Question: State the chart type depicted above.
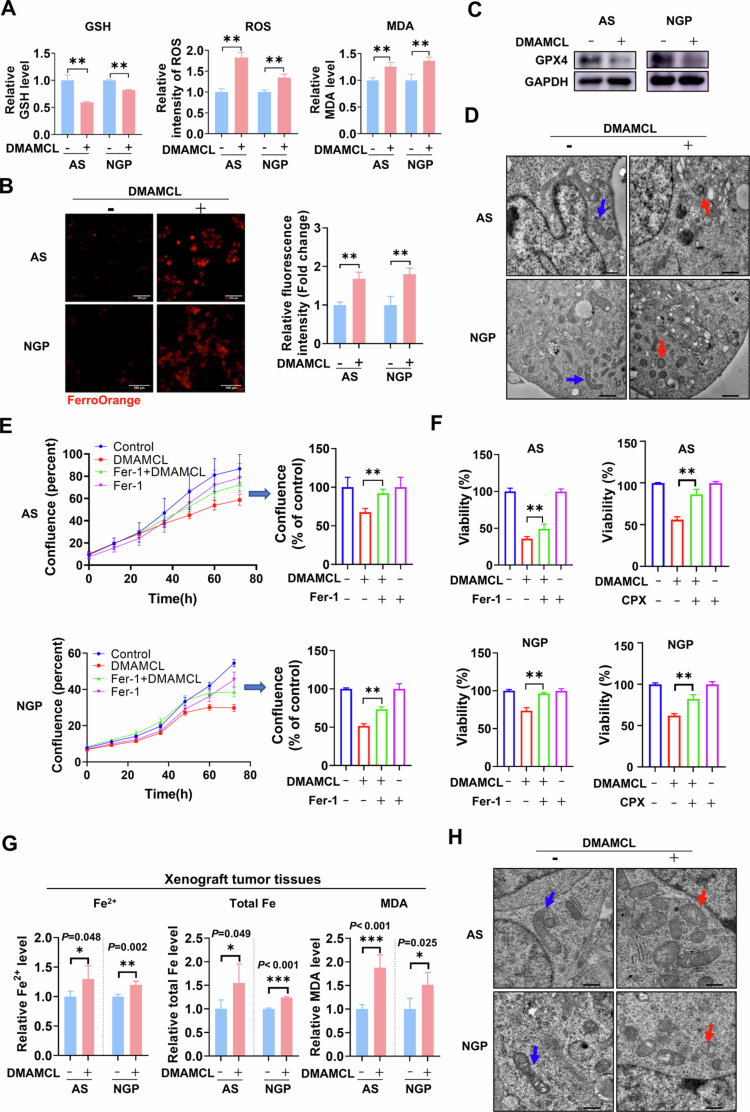
Answer: line